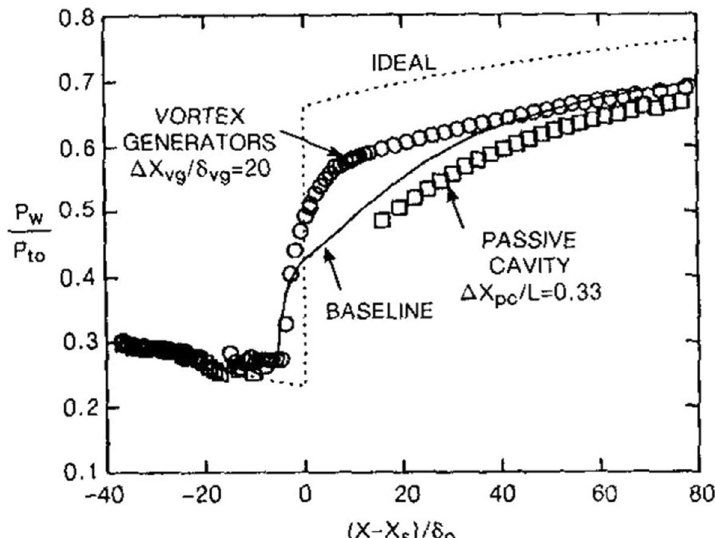
Fig. 8 Wall static pressure distributions